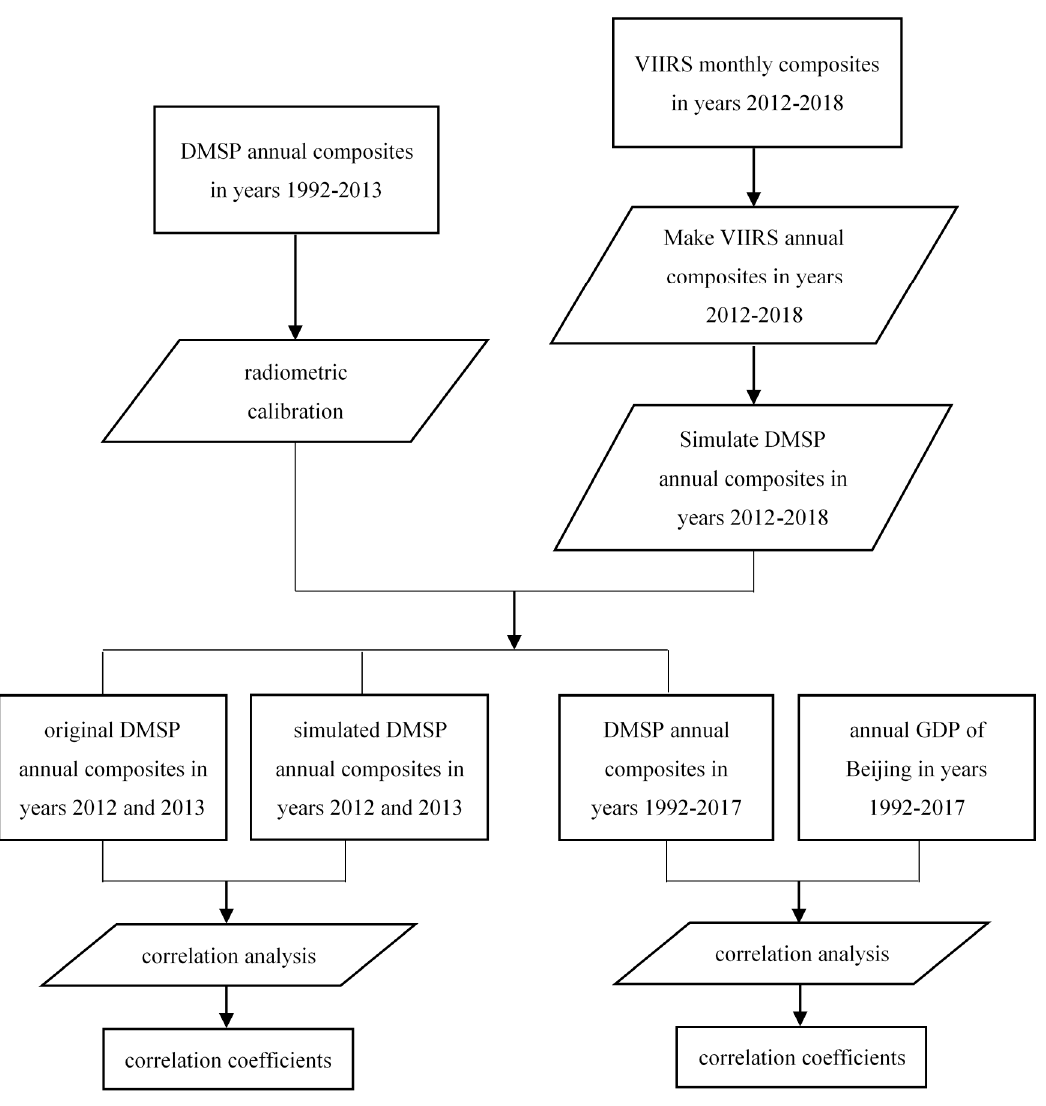
Figure 2. NTL processing and model evaluation.